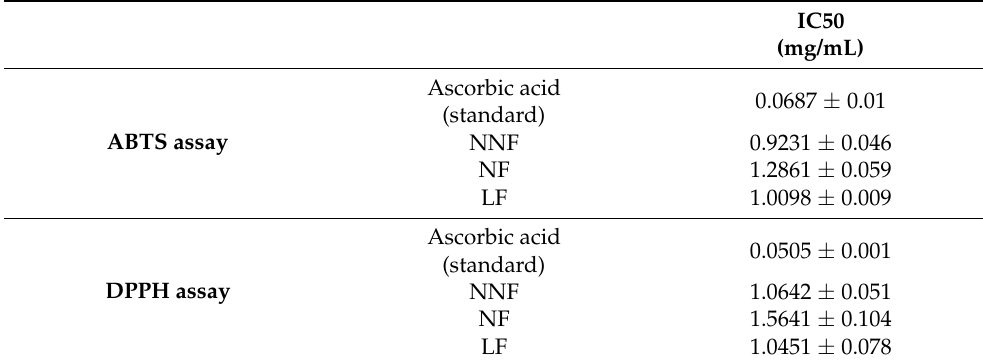
Table 2. ABTS and DPPH antioxidant activity. Data are expressed as means ± SD ( n = 3).